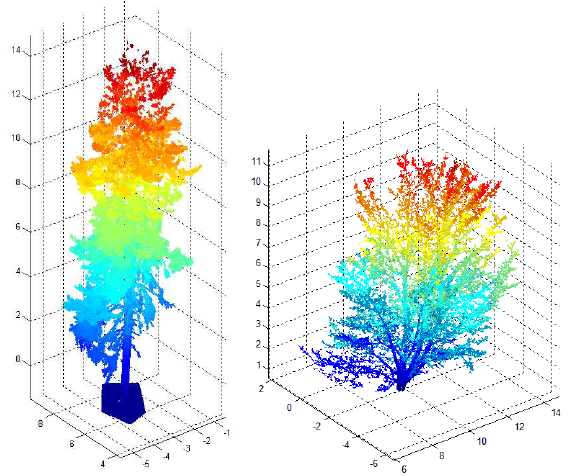
Figure 1: Point clouds from a coniferous (left) and a deciduous tree